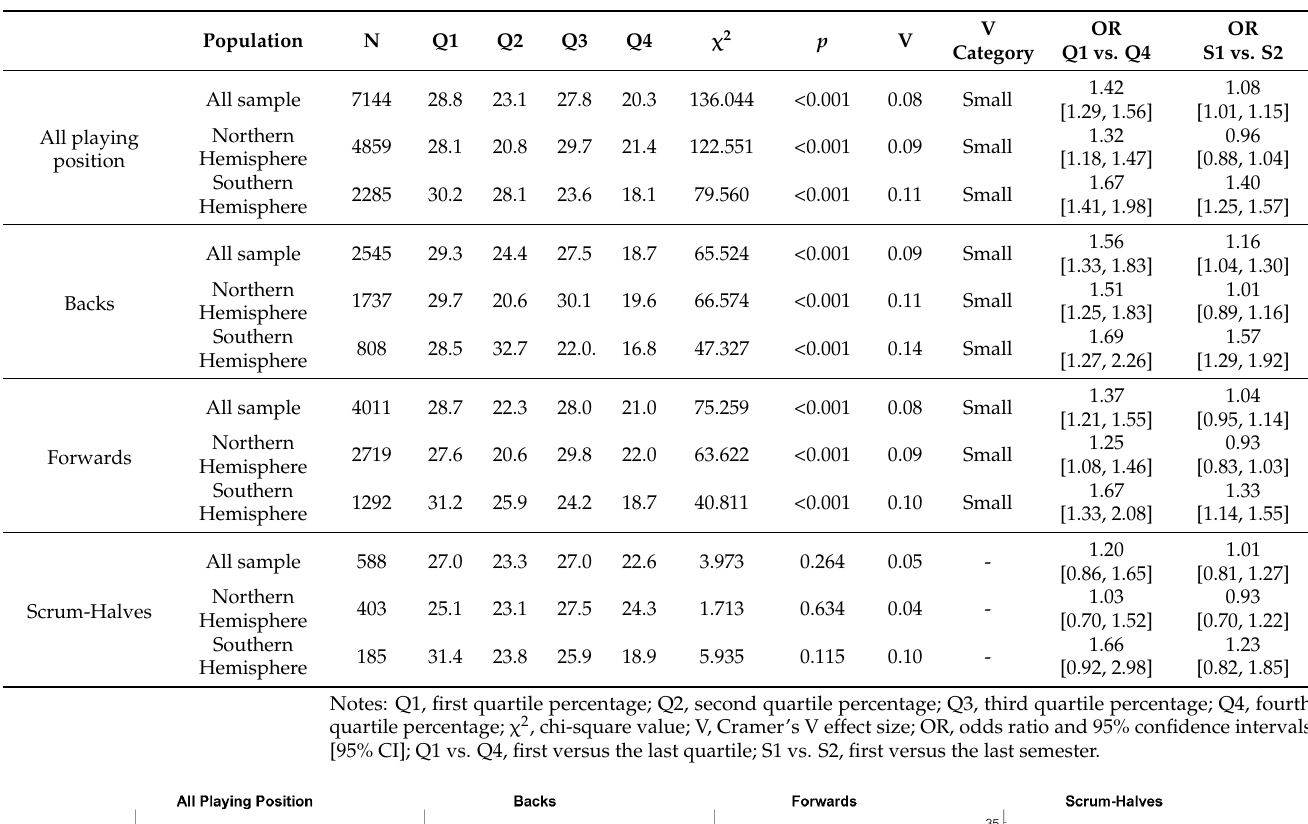
Table 1. Birth quartile distribution, chi-square value, and odds ratio analysis considering the different playing positions.